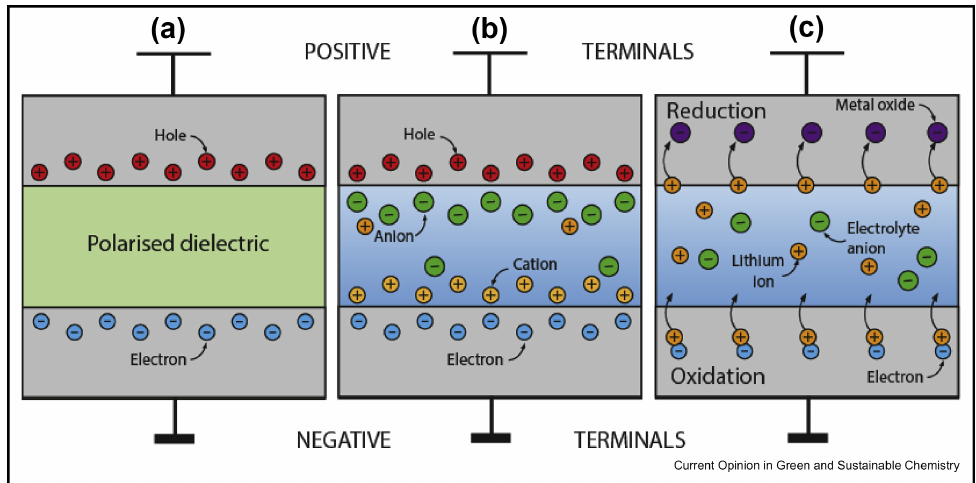
Figure 1. Schematic illustration of the differences in electrical charge storage mechanisms between ( a ) a dielectric capacitor with wide charge separation and polarised dielectric, ( b ) an EDLC with much closer charge separation partially provided by ions in the electrolyte, and ( c ) a Li ion-type redox battery with charge transfer occurring across the electrode-electrolyte interface. The thin upper line on each represents the positive terminal, while the thick lower line is the negative. Reprinted with permission from Ref. [5]. 2019,